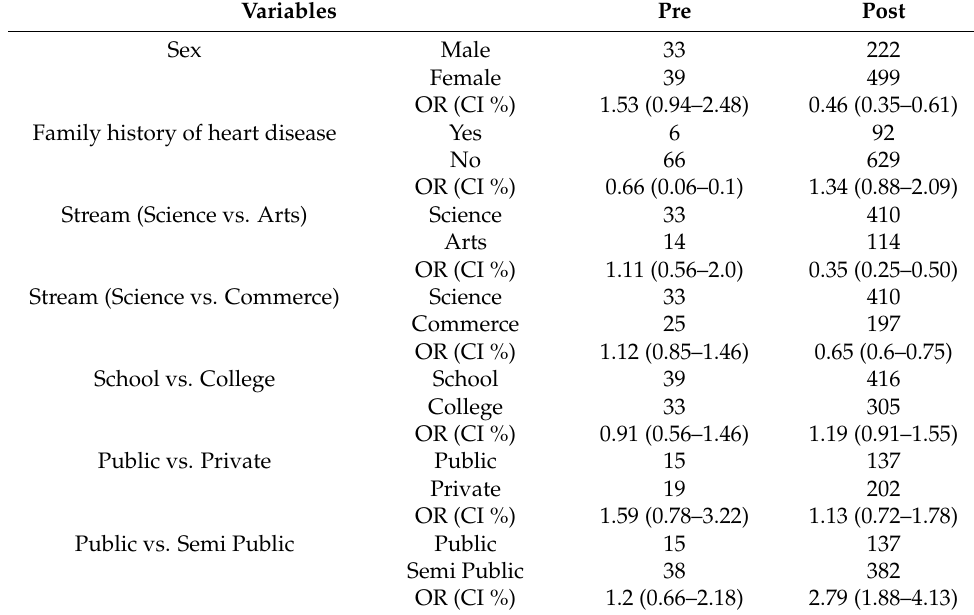
Table 5. Knowledge about risk factors of stroke in different